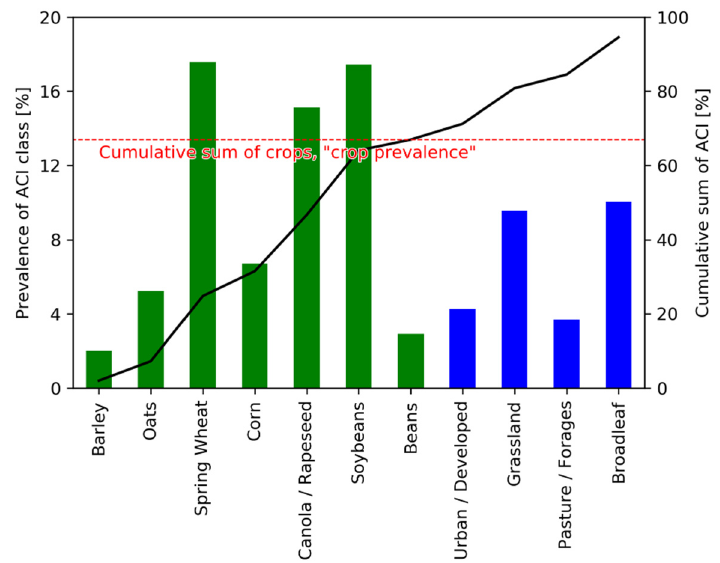
Figure 6. Plot of the prevalence of each ACI land cover class, colored by crop (green) and non-crop (blue). Because only ACI land cover classes covering more than 2% of the valid pixels are considered, we indicate the respective crop prevalence (horizontal line) and cumulative sum. The figure shows that the analysis can be reduced to 11 ACI land cover classes while still representing nearly all pixels (95%).